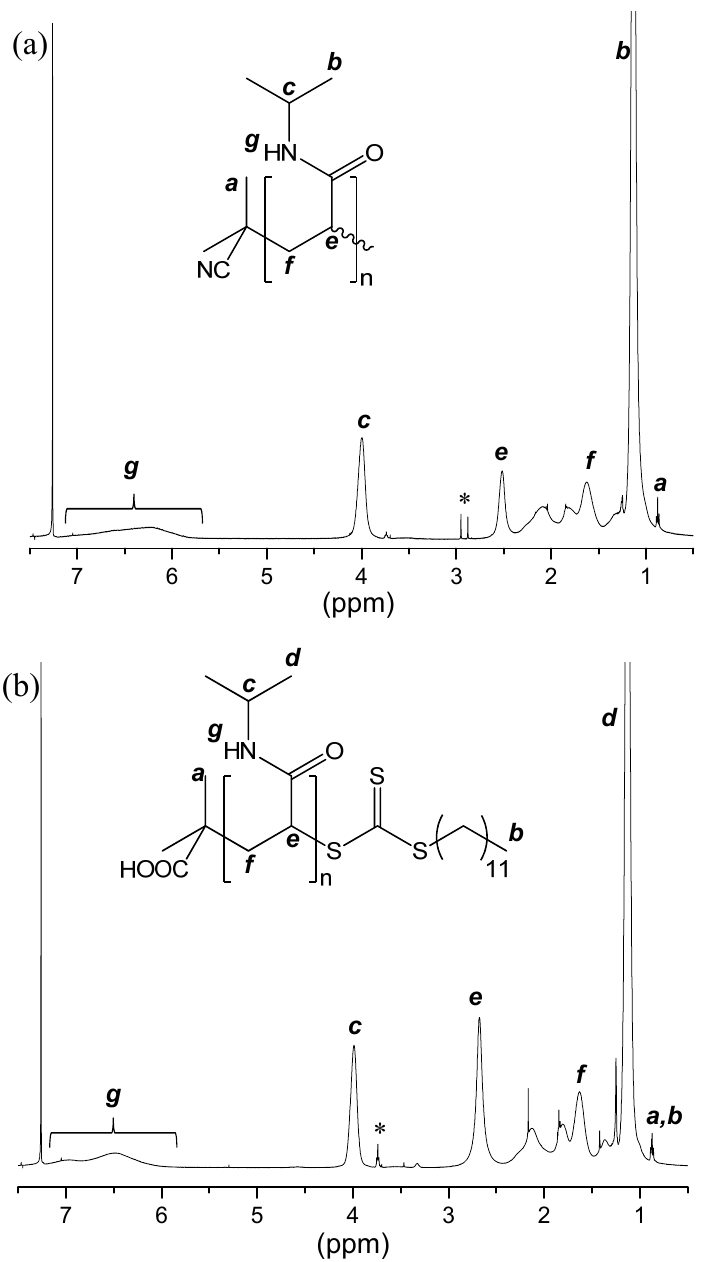
Figure A1. 1 H NMR spectra of ( a ) sample I and ( b ) sample II. The traces of solvents are marked by asterisks.